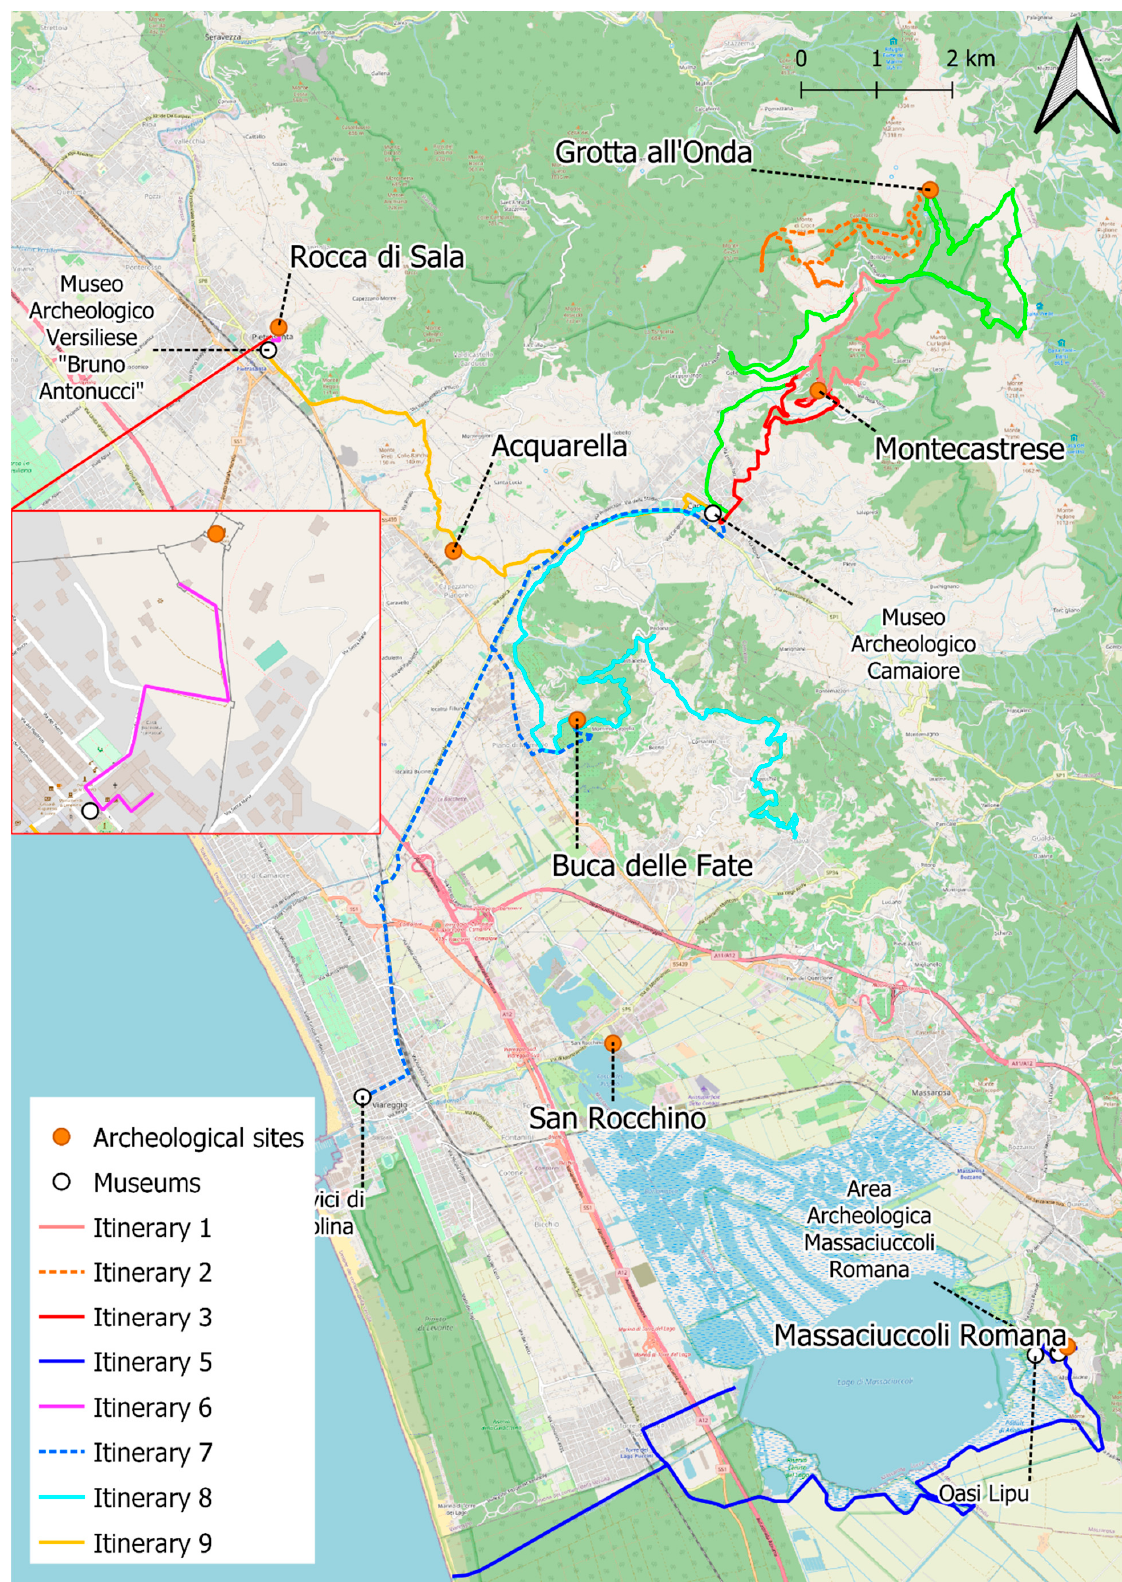
Figure 4. Real itineraries linking the archaeological sites with the museums, as proposed in this study. These initiatives can help to incentivise inland tourism. Background: OpenStreetMap.